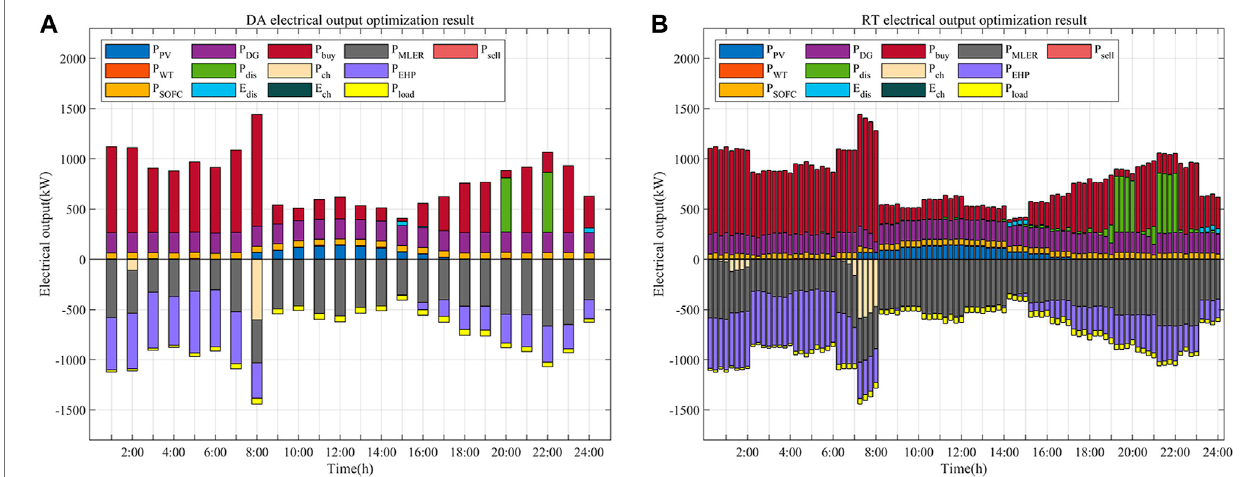
FIGURE 10 | DA and RT electric power output optimization